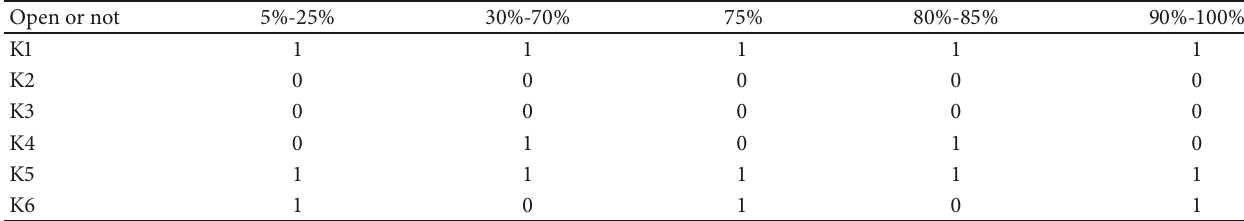
Table 23: Impact of demand’s ST in secondary markets for ferrous